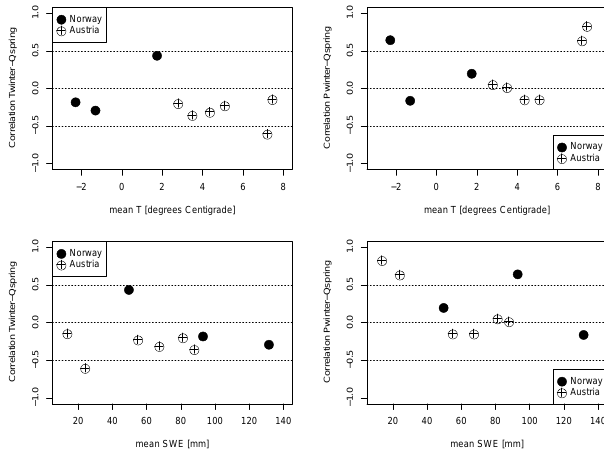
Figure 9. Correlation between Q spring and T winter / P winter for snowmelt drought events in Austrian and Norwegian catchments in relation to catchment mean air temperature and snow cover. 50